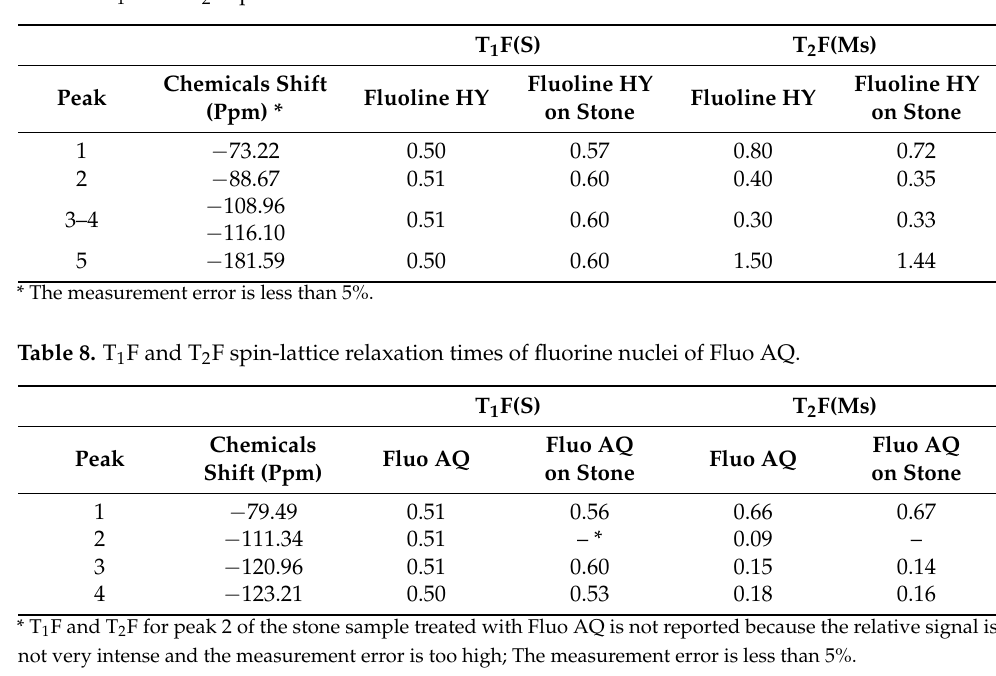
Table 7. T 1 F and T 2 F spin-lattice relaxation times of fluorine nuclei of Fluoline HY.